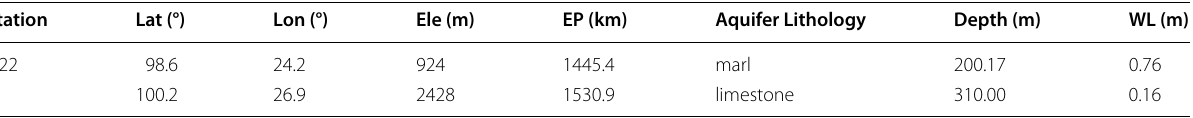
EP is the epicenter distance, WL stands for the maximum coseismic water-level variation